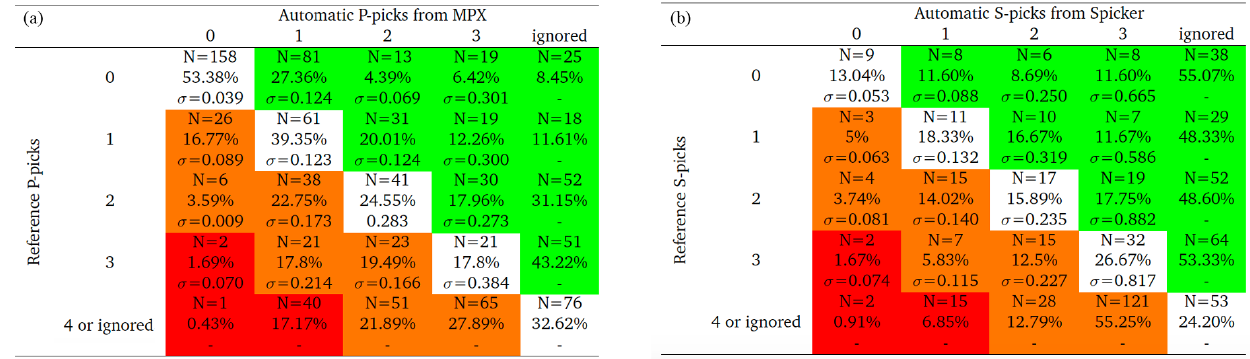
hand, it seems that Spicker ignored a large number of picks (high hit rates in the most right column of the Spicker ma- trix). This is eminent for picks with manual quality class 0 that are potentially associated with the closest stations based on human